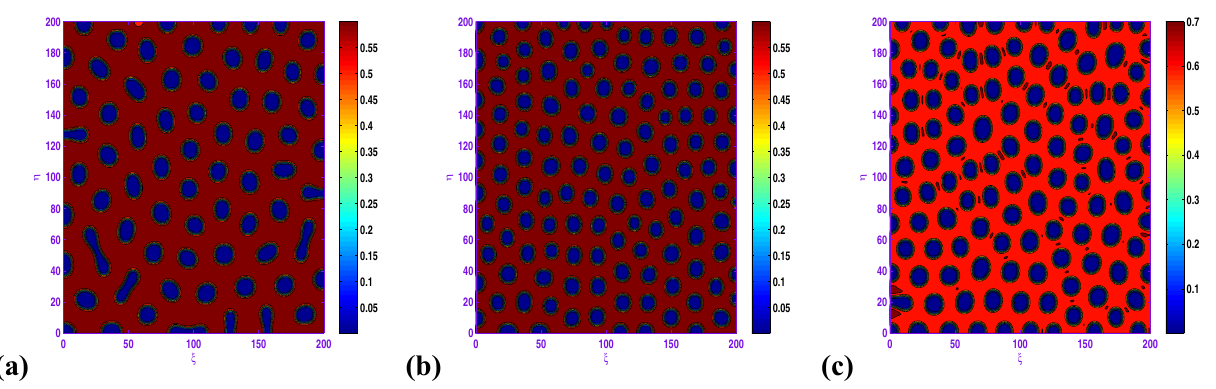
Figure 11. Transition of spatial dynamics of the prey population ( u ) in the model (9) at t = 5000 , for the set: a = 0.6 , b = 0.98 , β = 1.1 , d = 0.3 , d